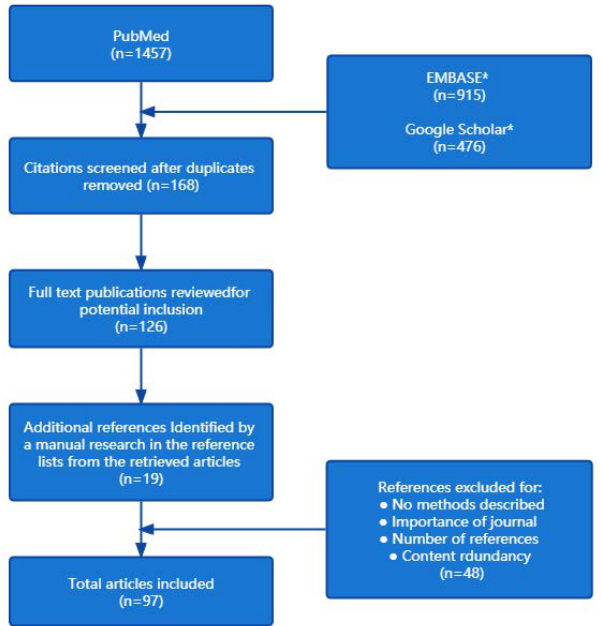
Figure 1. Flowchart of the literature selection. * Google Scholar and EMBASE were auxiliary databases used if the full text of a particular article was not found in PubMed.